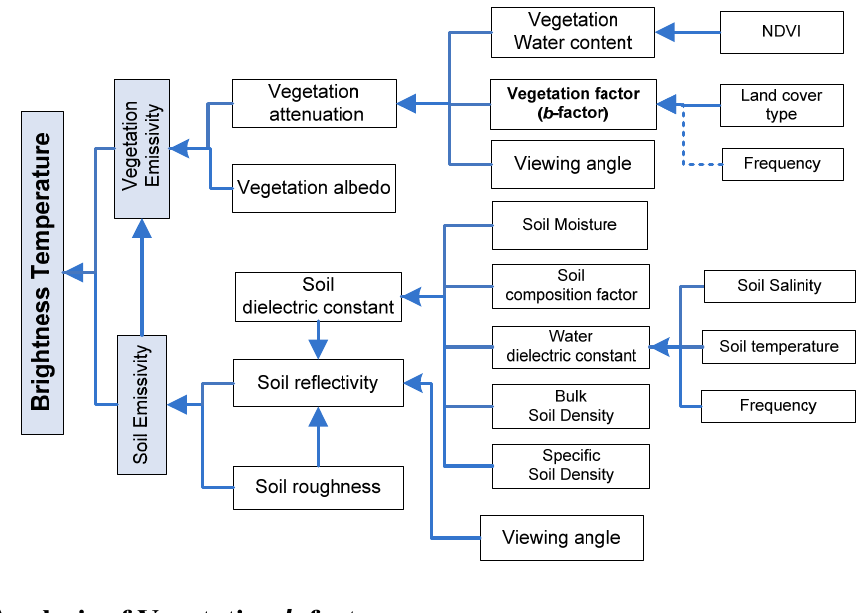
Figure 1. Flow chart of the microwave emission model for soil moisture